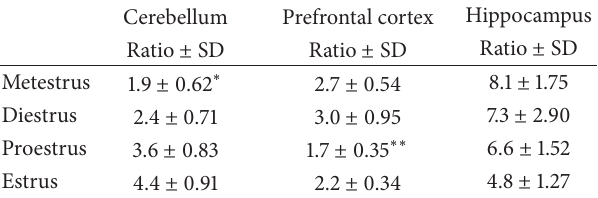
Table 1: The LAP/LIP ratio in the different brain areas throughout the estrous cycle. The ratio was expressed as the average of both LAP1andLAP2isoformscontenttothatoftheLIPisoform.Thedata represent the ratios in each estrous cycle phase (metestrus, diestrus, proestrus, and estrus) in the different brain areas (cerebellum, prefrontal cortex, and hippocampus) with their respective standard deviation